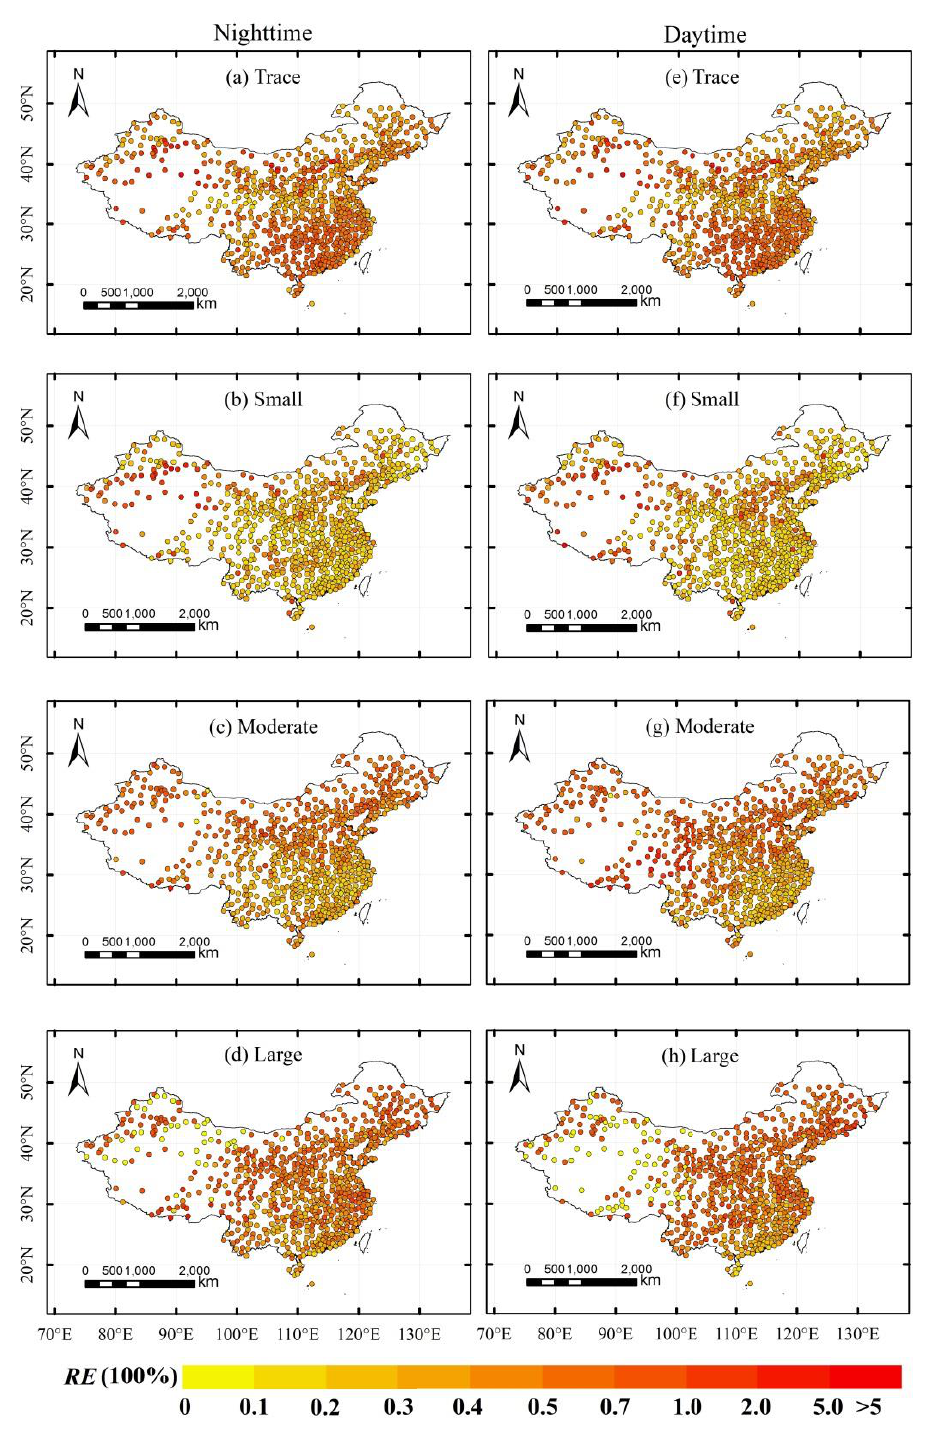
Figure 11. Spatial distribution of relative error from TRMM 3B42 data and gauge data for precipitation frequencies during ( a – d ) nighttime and ( e – h ) daytime for di ff erent categories of intensity over mainland China. From top to bottom are days with a trace amount of rain ((0.1 ≤ P < 1 mm (12 h) − 1 )), a small amount of rain (1 ≤ P < 10 mm (12 h) − 1 ), a moderate amount of rain (10 ≤ P < 25 mm (12 h) − 1 ), and a large amount of rain (P ≥ 25 mm (12 h) − 1 )).